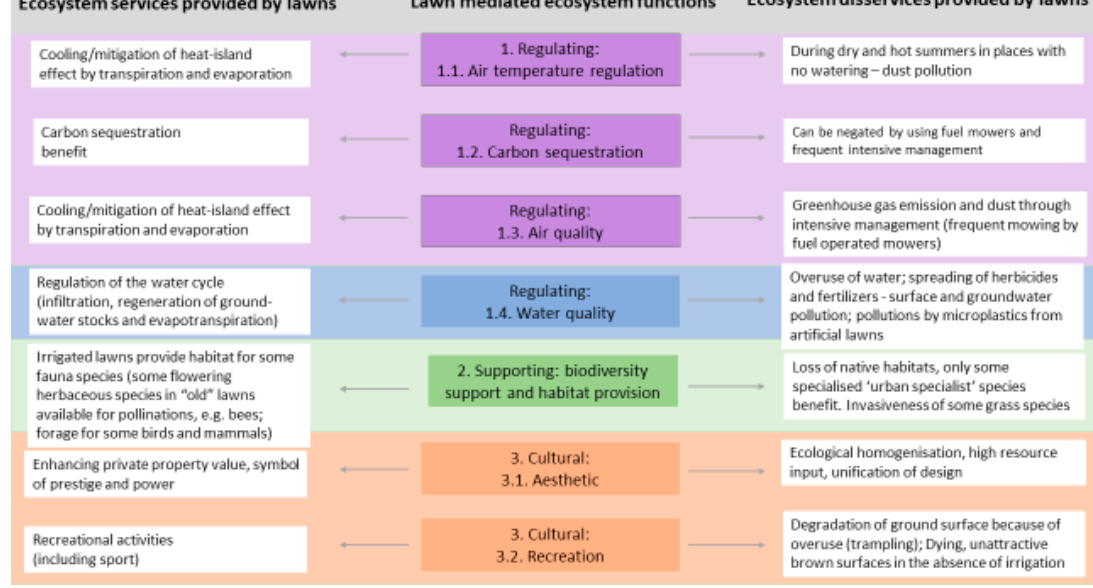
Figure 4. Ecosystem services and disservices provided by